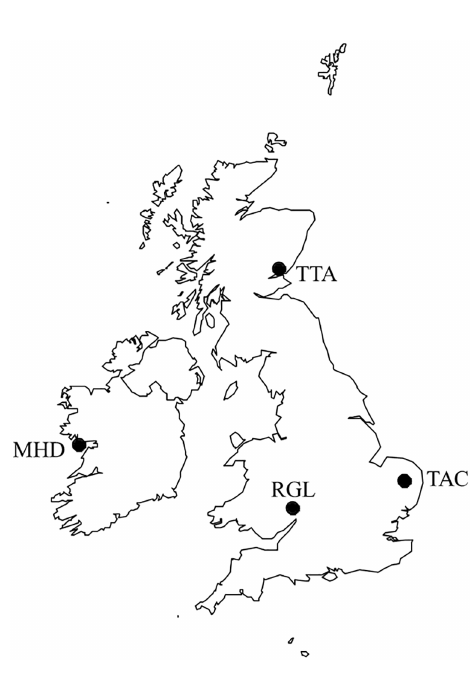
Figure 1. Location of UK DECC network stations, showing from north to south: TTA, Angus, UK; MHD, Mace Head, Ireland; TAC, Tacolneston, UK; and RGL, Ridge Hill,